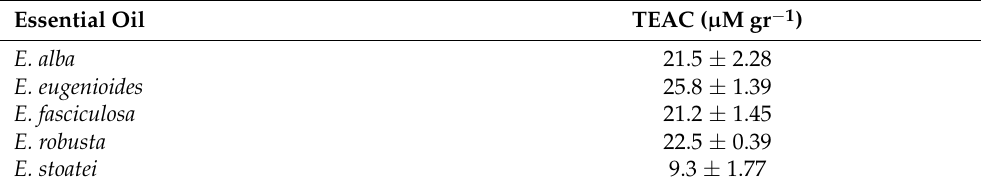
Table 4. Antioxidant activity according to the ABTS assay. Data are expressed as the mean ± SD of three